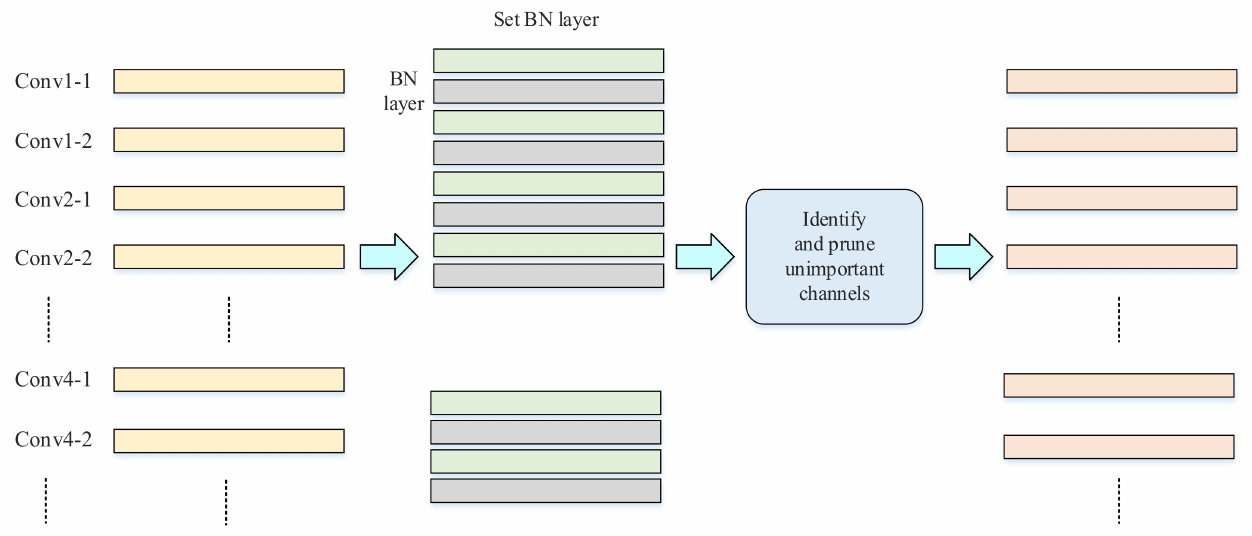
Figure 7. Schematic diagram of channel-level pruning